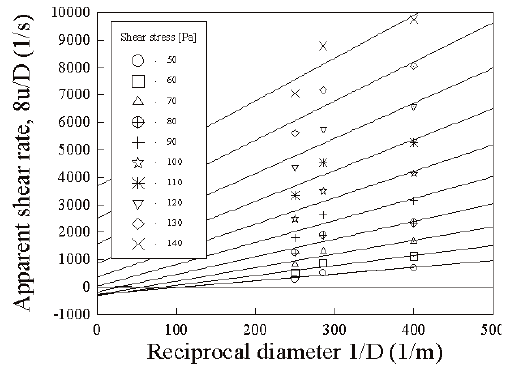
Figure 6 (left): Flow curves for a 0.3% PEO foam for different capillary diameters. Figure 7 (right): Application of the Mooney method for a 0.3% PEO foam (shear rate as a function of 1/D at given shear stress). A straight line was fit to the experimental data points for each wall stress using the least squares